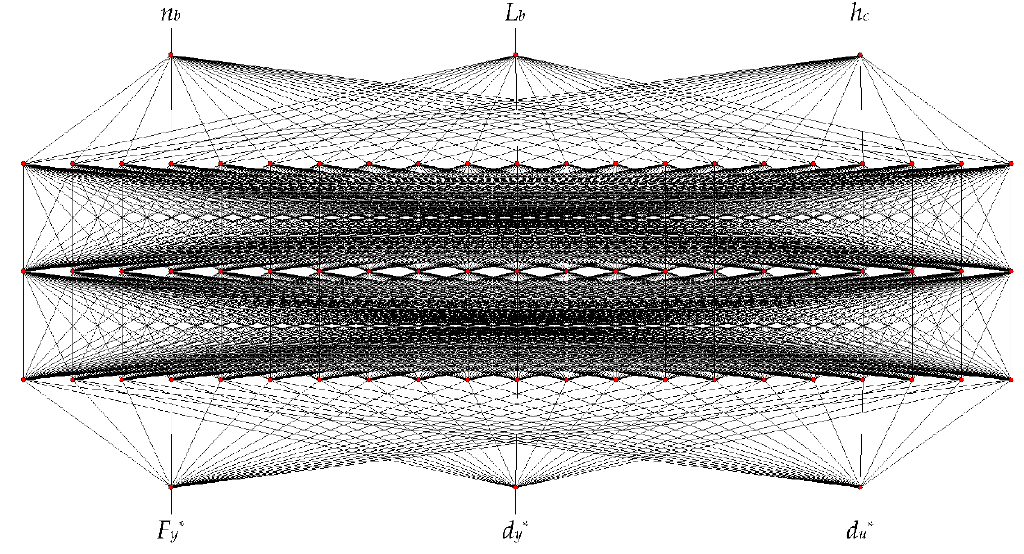
Figure 7. Adopted neural network architecture.